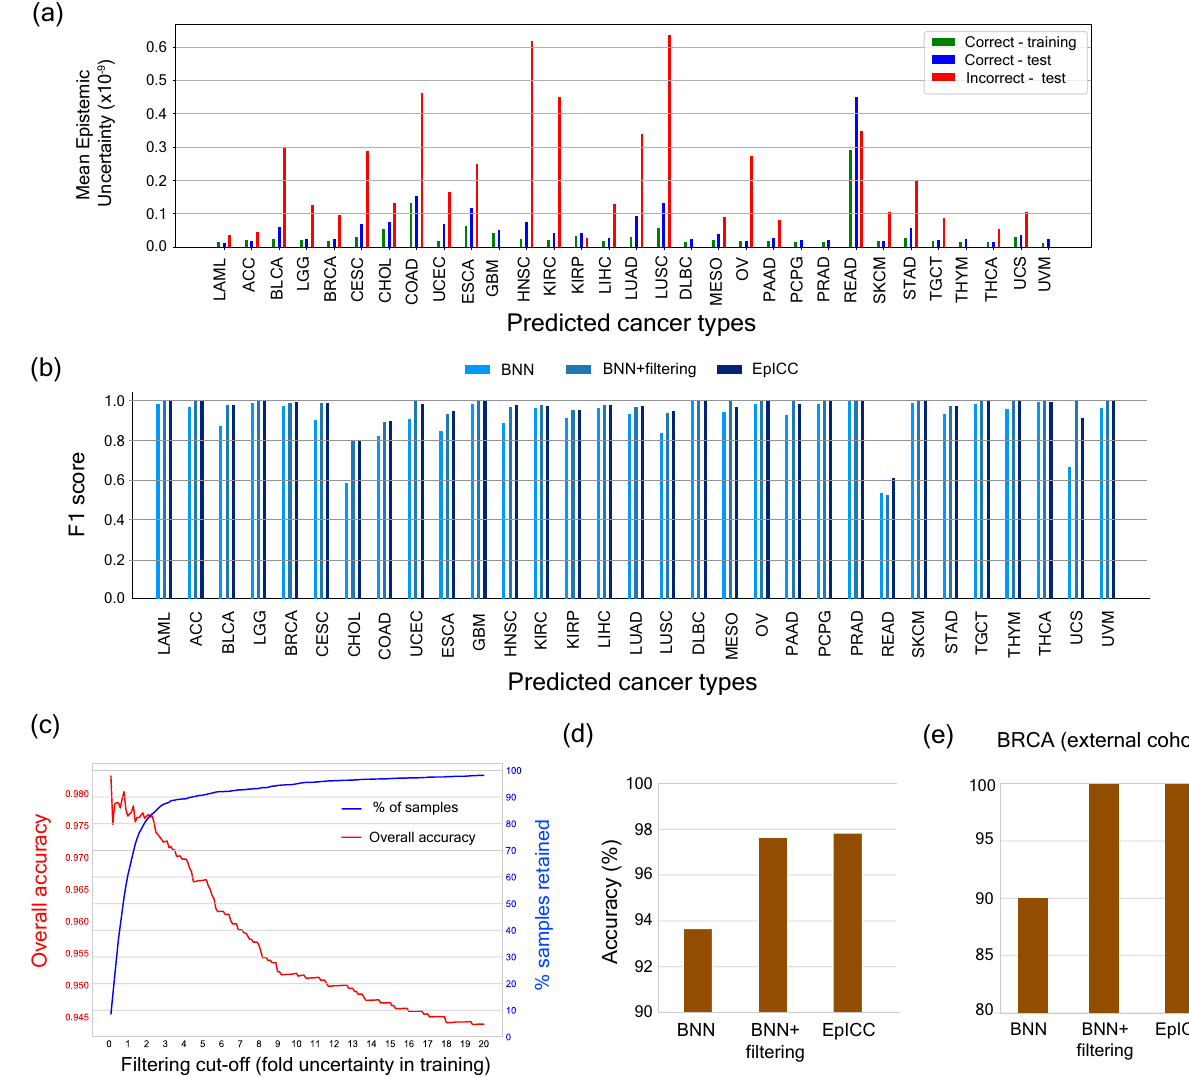
Figure 3. Cancer classification accuracy improves with uncertainty correction. ( a ) Plots showing the comparison of uncertainty on the correct and incorrect predictions. The green-coloured bars represent the mean uncertainty of correct predictions on training data, the blue bars show the mean uncertainty of correct predictions on test data and the red bars show the mean uncertainty of incorrect predictions on the test data. ( b ) Comparison of F1 scores of the prediction made by BNN, after filtering the predictions based on mean training uncertainties of correct predictions and after applying uncertainty correction (EpICC). ( c ) Variation in overall accuracy and the percentage of samples retained for prediction using different values of filtering cut- off. ( d ) Comparison of overall classification accuracy of BNN, BNN with uncertainty filtering and EpICC for classification of cancer types. ( e ) Percentage accuracy of classification of BRCA from external cohort (ICGC) with BNN, BNN with uncertainty filtering by mean training correct predictions, and by